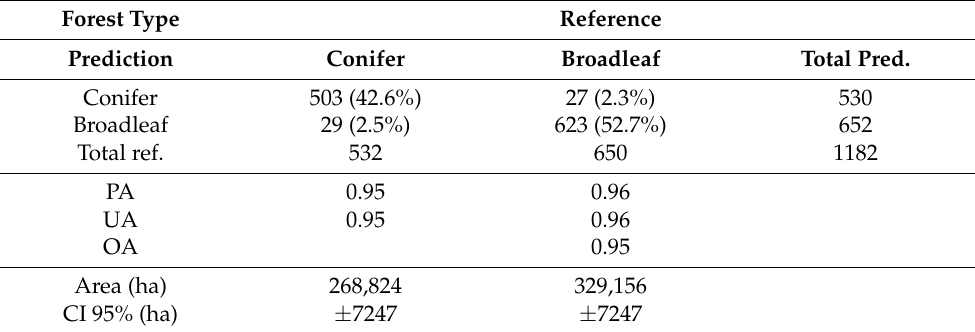
Table 3. Confusion matrix and producer (PA), user (UA), and overall (OA) accuracy statistics of the forest type classification based on the independent evaluation data. Entries in the matrix represent the number of pixels and proportions in brackets. Forest area distribution to forest types and the corresponding 95% confidence interval (CI 95%) are based on the post-filtered forest area estimate (Table 2).